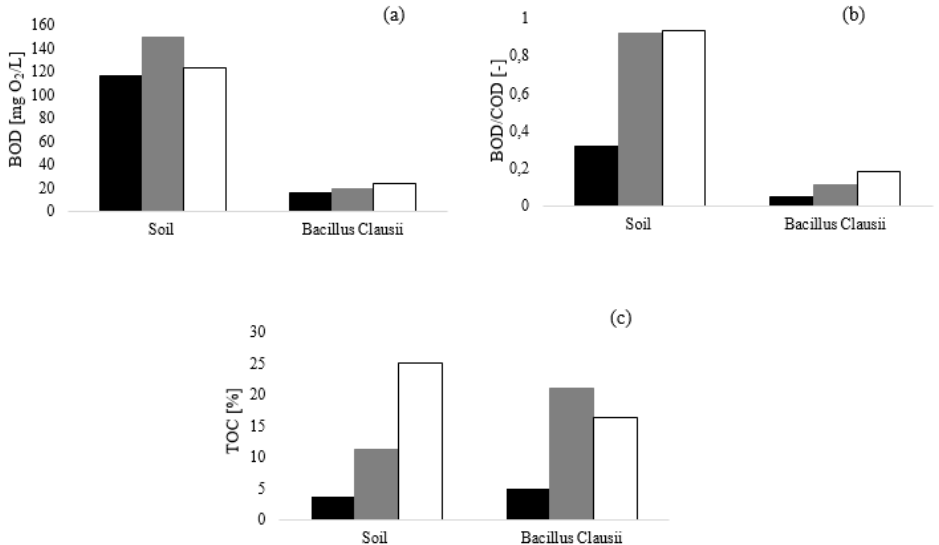
Figure 1. BOD ( a ), biodegradation index ( b ) and TOC removal ( c ) after five days in closed bottle tests. Conditions: 2.0 mL of Bacillus Clausii or inoculum from soil humus (soil) and 0.20% as concentration of the conditioning mixtures A (black), B (gray) and C (white) in demineralized water solutions.